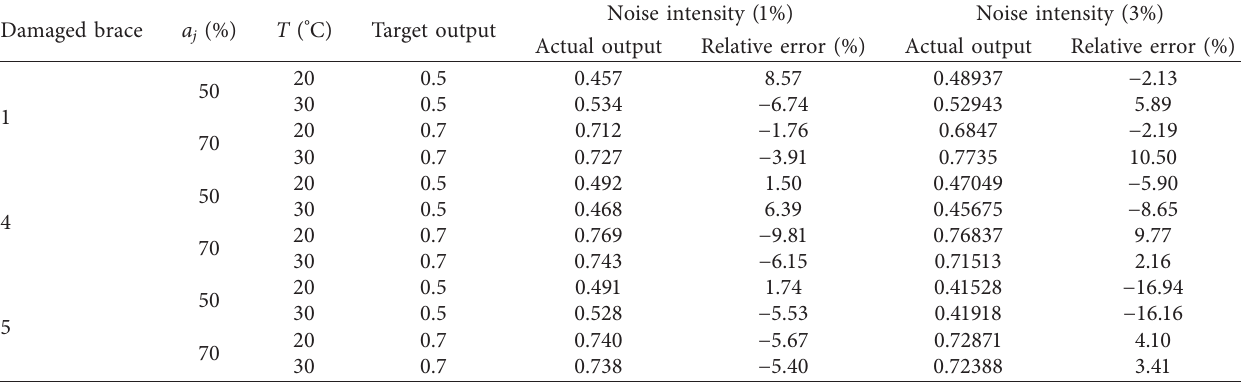
Table 9: The identification results of damage severities when one brace is damaged with noises. Damaged brace